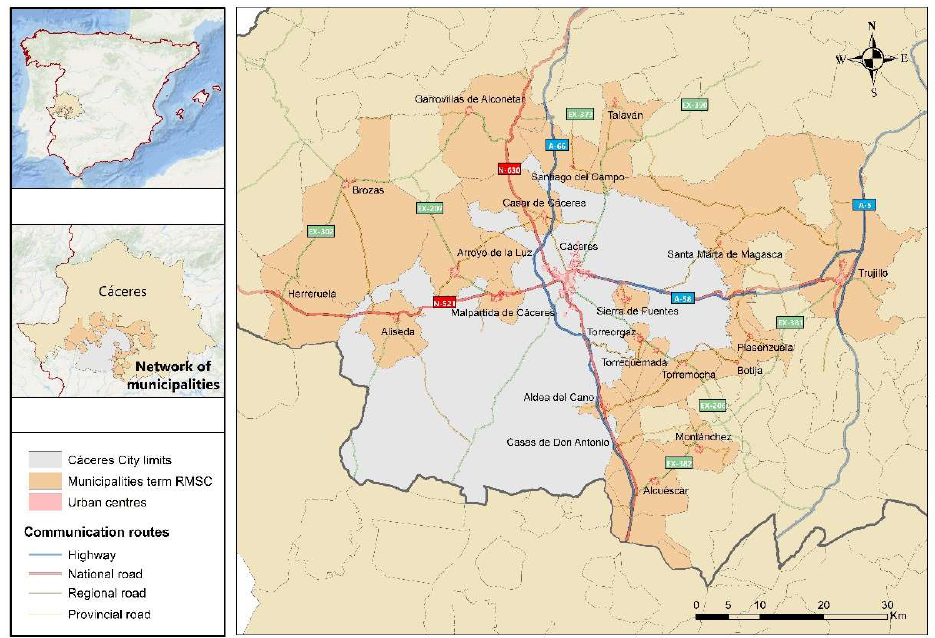
Figure 2. Location map of the study